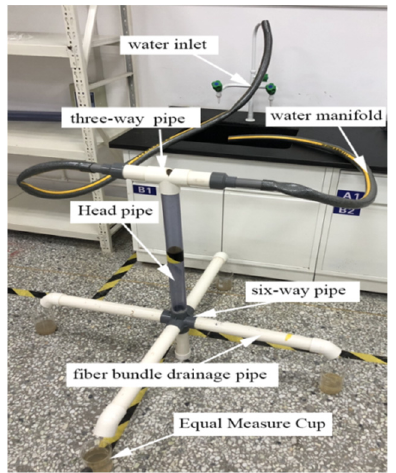
Figure 11. A statistical diagram of the number of clogged soil particles in the drainage pipe at dif- ferent inclination angles.